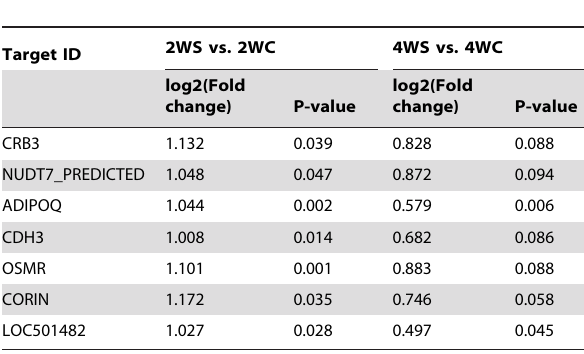
Table 2. Comparison of gene expression levels between groups undergoing 2 weeks of stress (2WS) and controls (2WC) and recovery from stress (4WS) and controls